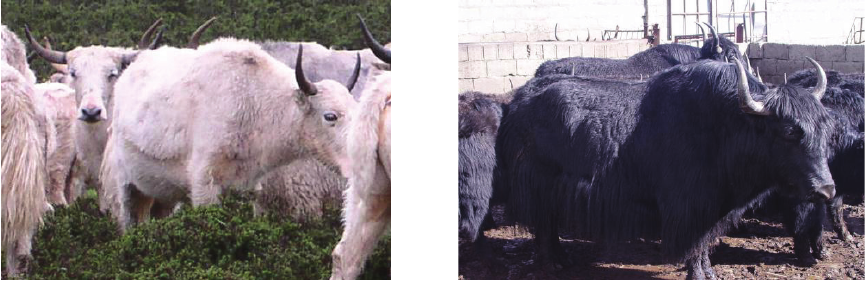
Figure 1: Pictures of Tianzhu yak (white) and Maiwa yak